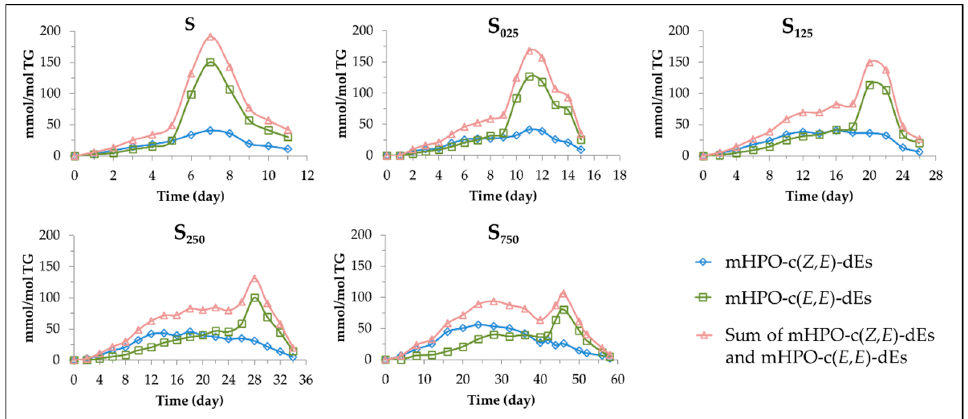
Figure 6. Evolution of the concentration of mHPO-c( Z,E )-dEs, mHPO-( E,E )-dEs and both types of hydroperoxides together, in samples S, S 025 , S 125 , S 250 and S 750 over the storage time at 70 °C, up to a very advanced oxidation stage.